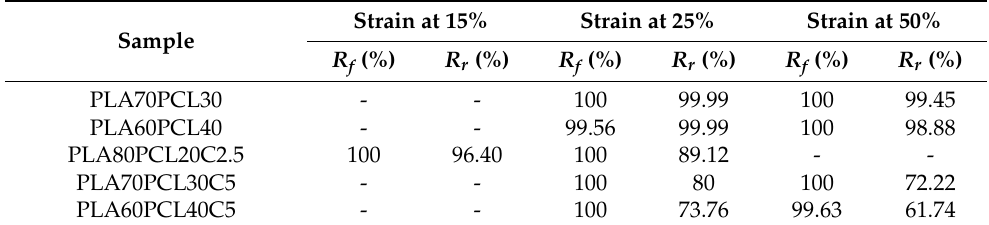
Table 4. Shape fixity and shape recovery values of studied PLA/PCL blends